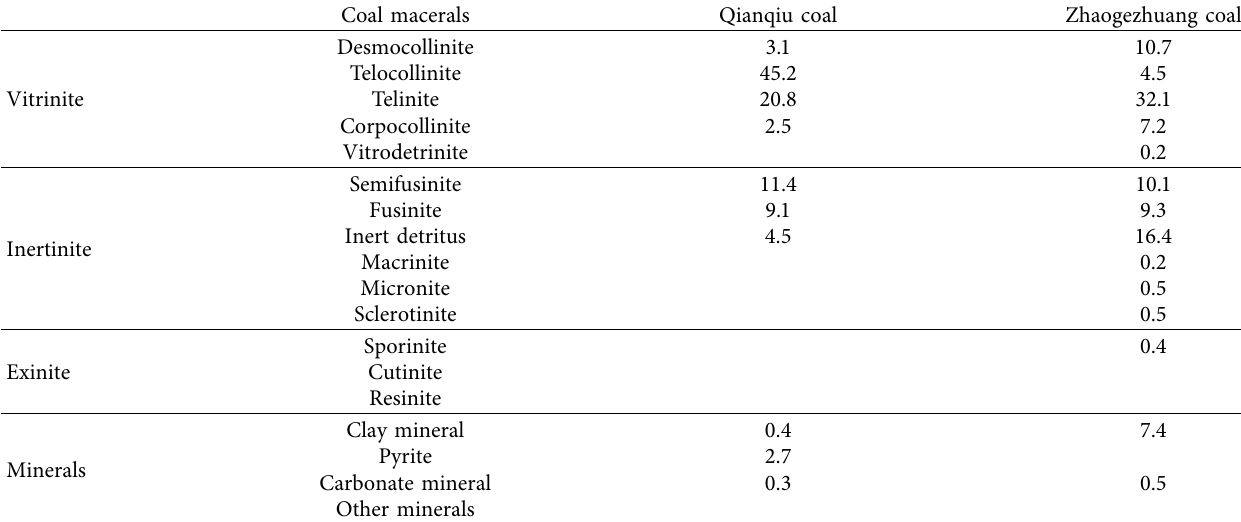
Table 4: Quantitative statistical results of coal samples’